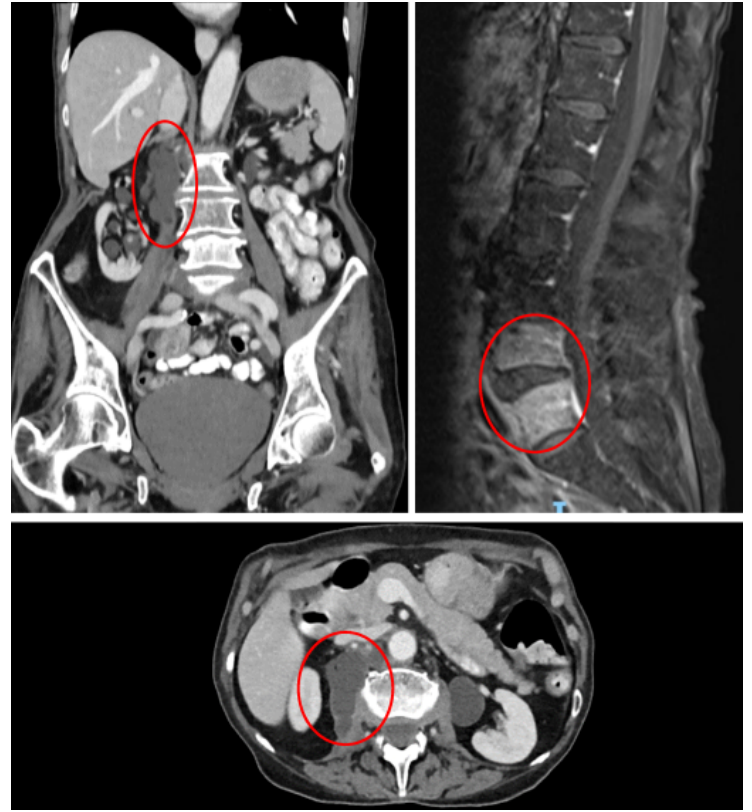
Figure 4: MRI scans showing psoas abscess and L4/5